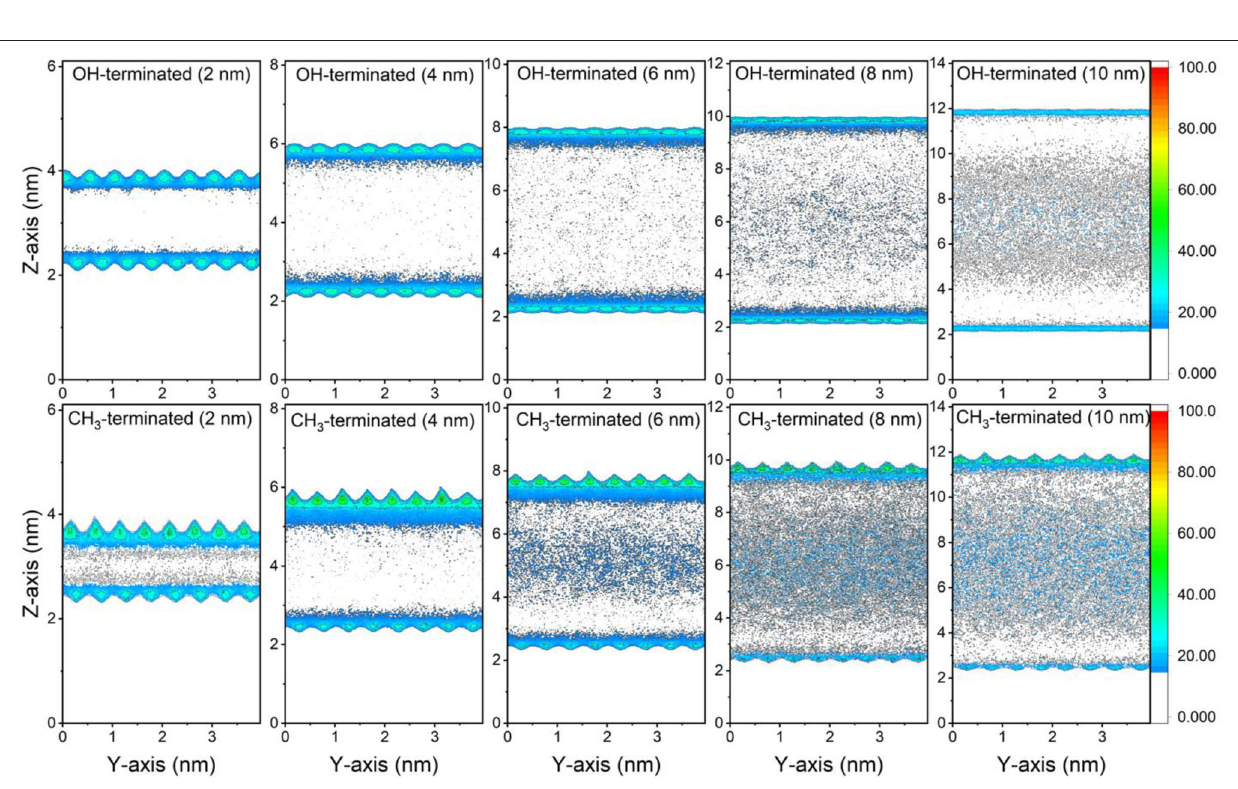
Frontiers in Climate |